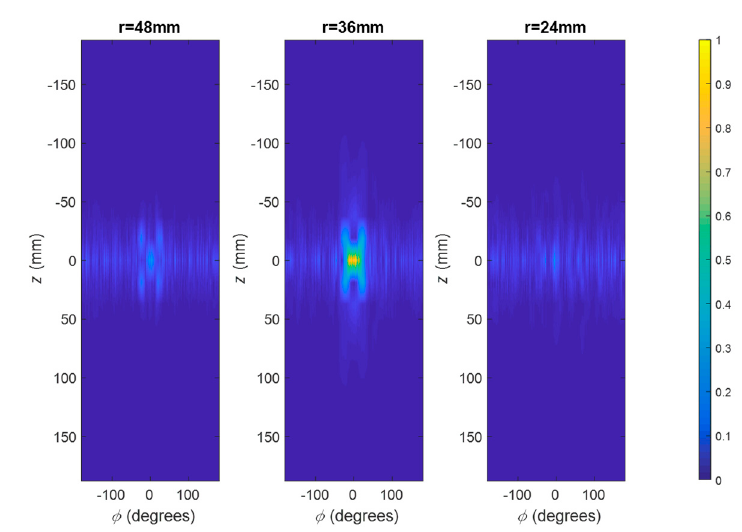
Figure 11. Normalized 3D reconstructed image of the object in Figure 10 on three imaged surfaces at radii of 48, 36, and 24 mm using double frequency data collected by eight receiver antennas.